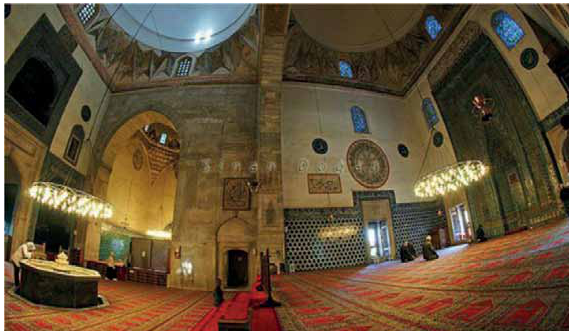
fig. 5. Bursa Green Mosque. Source: